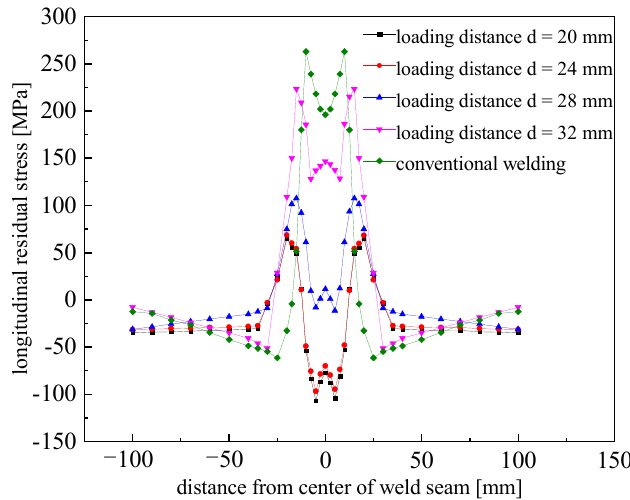
Figure 8. Comparison of the longitudinal residual stress in the middle section under different con- ditions.